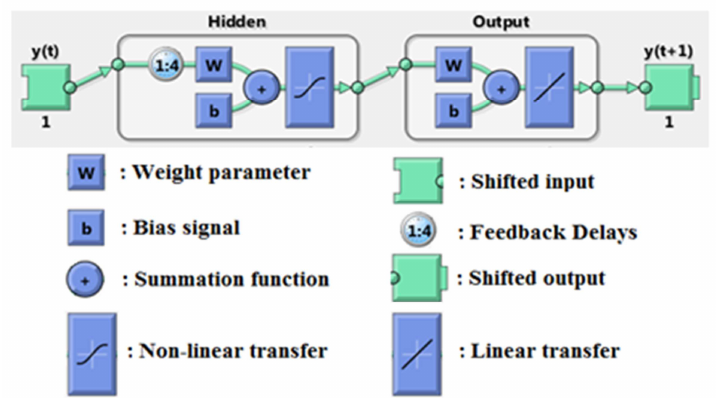
Figure 3. Neural network predicting structure with a hidden layer